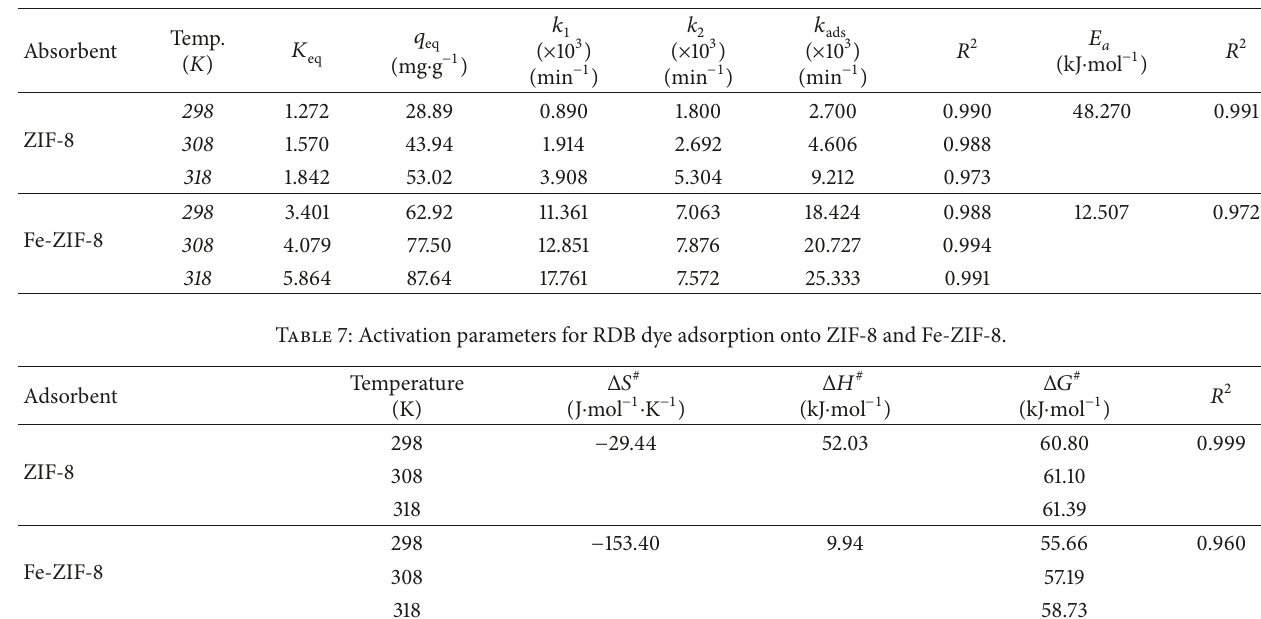
Table 6: Activation energy, equilibrium and rate constants for RDB dye adsorption, and rate constants for forward and reverse process of RDB adsorption onto ZIF-8 and Fe-ZIF-8.